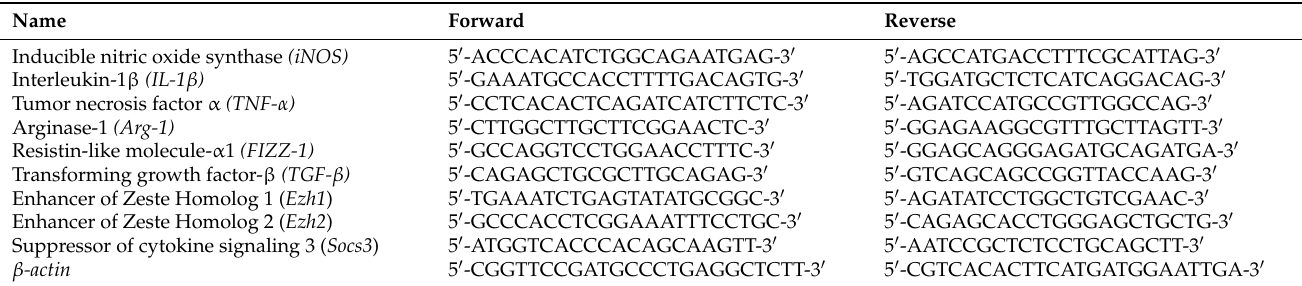
Table 1. Lists of primers used in the